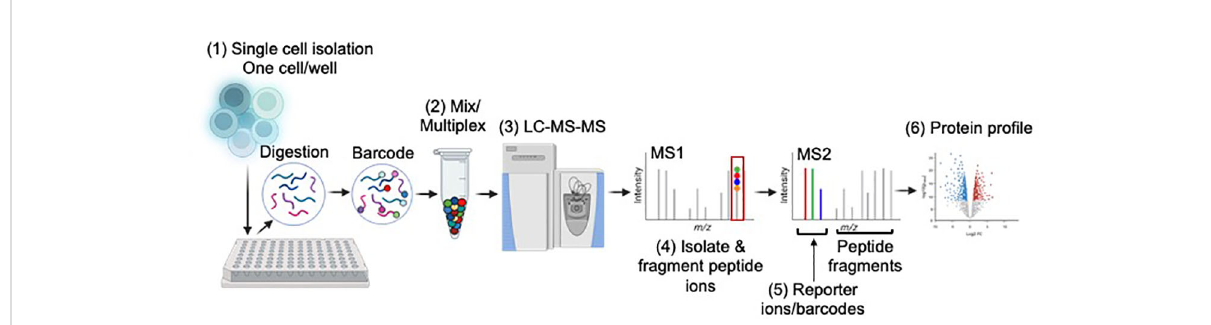
FIGURE 1 Basic overview of single-cell mass spectrometry work fl ow. Single-cell proteomics tends to use a “ bottoms-up ” approach. (1) Single cells are sorted into multi-well plates (one cell/well), lysed and digested via trypsin. Peptides in each well are labelled with barcodes, or tags, so researchers can determine how much of a given protein is present in each cell. One commonly used tag, tandem mass tag (TMT) can differentiate up to 18 samples in a single mixture. (2) TMT requires samples to be labeled individually then mixed for multiplexing. (3) Mixed samples are injected into the LC-MS. (4) Individual peptide species are ionized, isolated, and fragmented. (5) Analysis of the peptide fragments and barcodes allows for peptide sequence and protein quanti fi cation at the single-cell level, respectively. (6) Proteome pro fi ling revealing protein expression of single cells is obtained. Image developed using